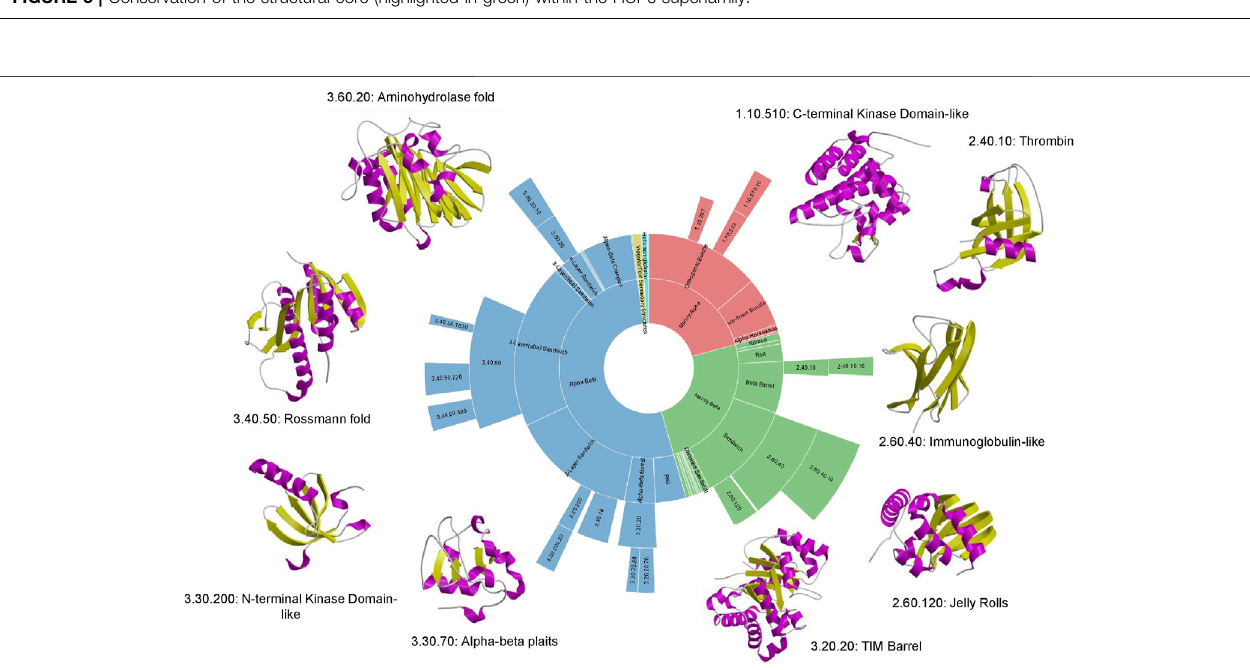
FIGURE6| Top9 “ super-folds ” inCATH v4.3.The inner wheel shows theproportion ofstructuresthatfallintoeach class, architecture, foldgroup andsuperfamily respectively.